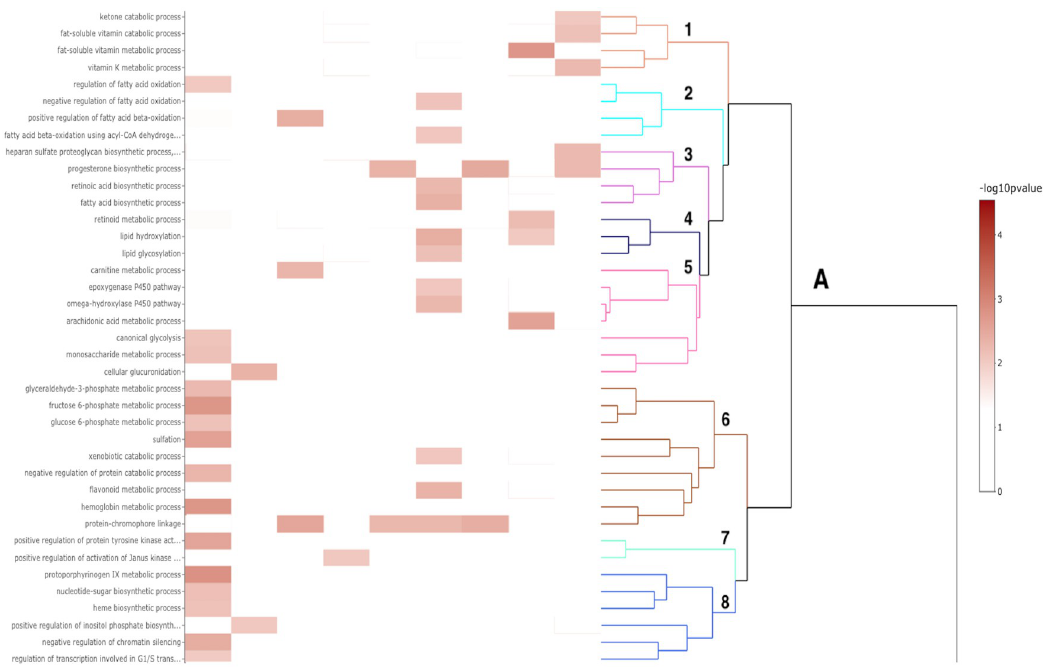
Fig 5. A heat-map showing the clustering of GO biological process terms. Branch A refers to the first main branch for hierarchical clustering based on the semantic similarity between GO terms. Clusters are labeled 1–8, starting at the top. The color of the cell corresponds to the associated p-value from the enrichment